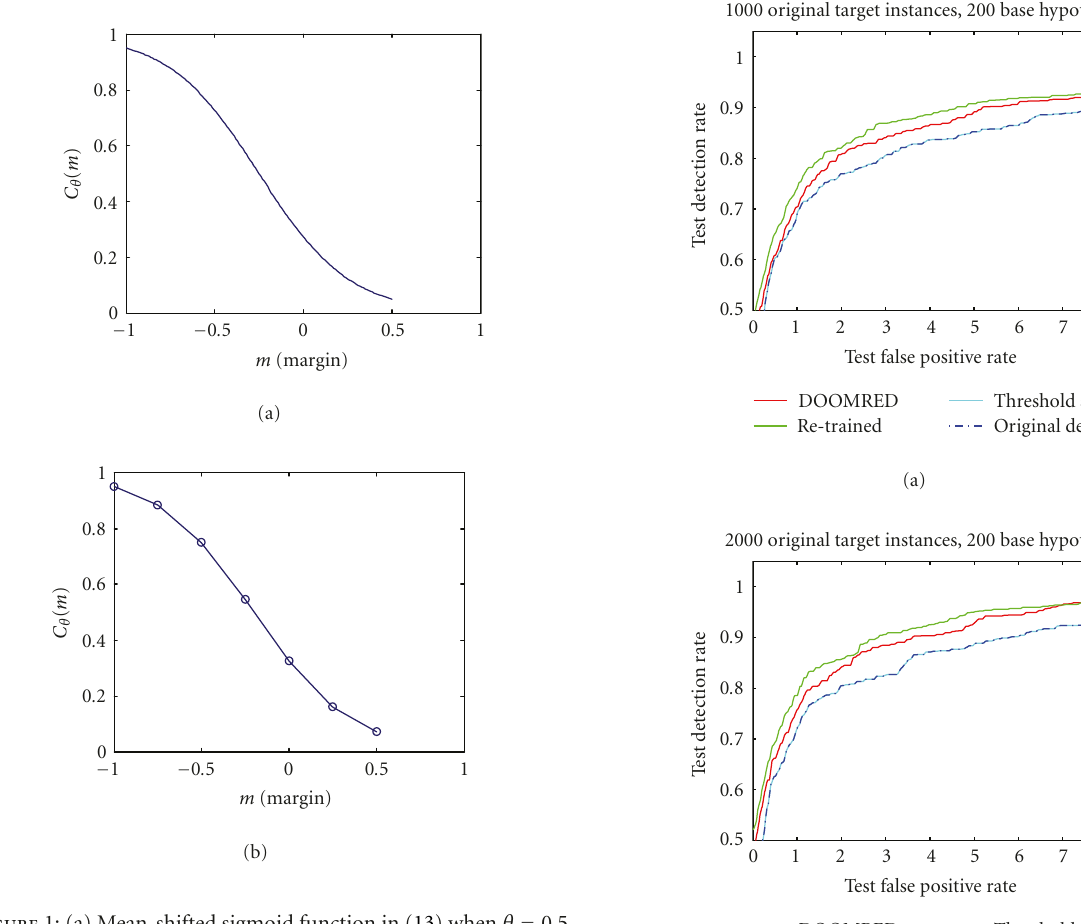
Figure 1: (a) Mean-shifted sigmoid function in (13) when θ = 0 . 5. (b) Digitized version of (a) when the margin is segmented in the size 0.25.